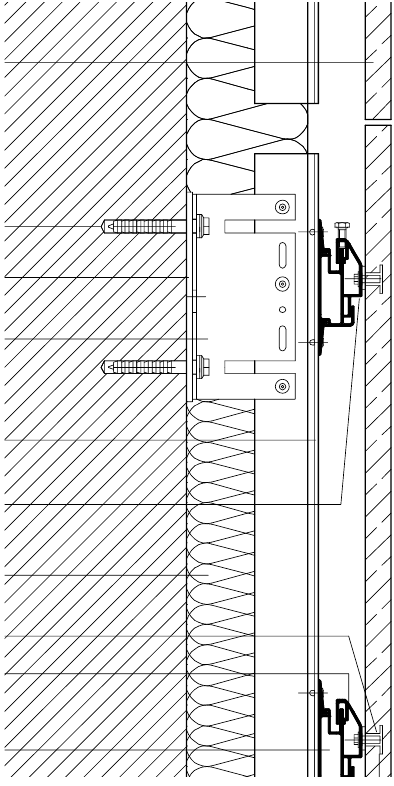
Figure 1. Principle cross-section curtain wall façade.